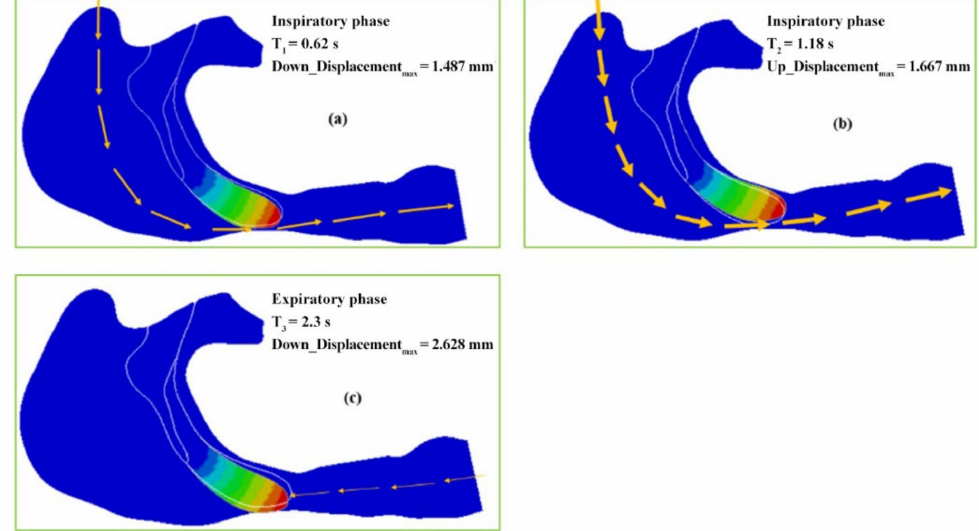
Figure 8. The maximum deformation and the one-way valve effect under apnea: ( a ) the soft palate moves to the posterior wall of the pharynx during inspiration phase, ( b ) the airway reopens during the inspiration phase, and ( c ) the airway is stenosed during expiration